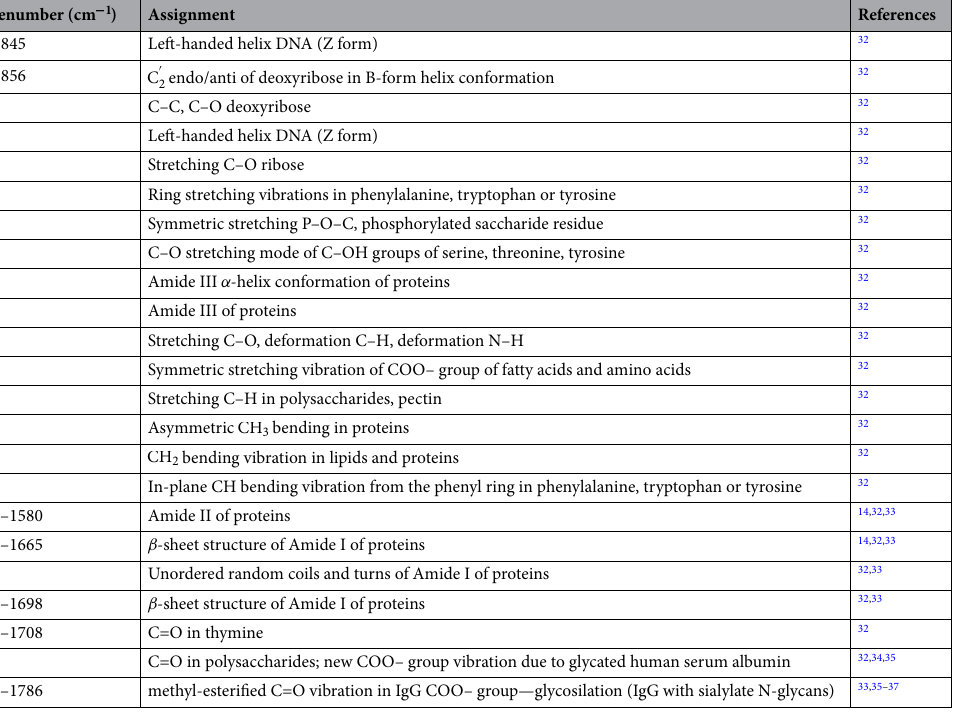
Table 2. Assignments for the main vibrational bands of micro-FTIR blood serum (Fig.